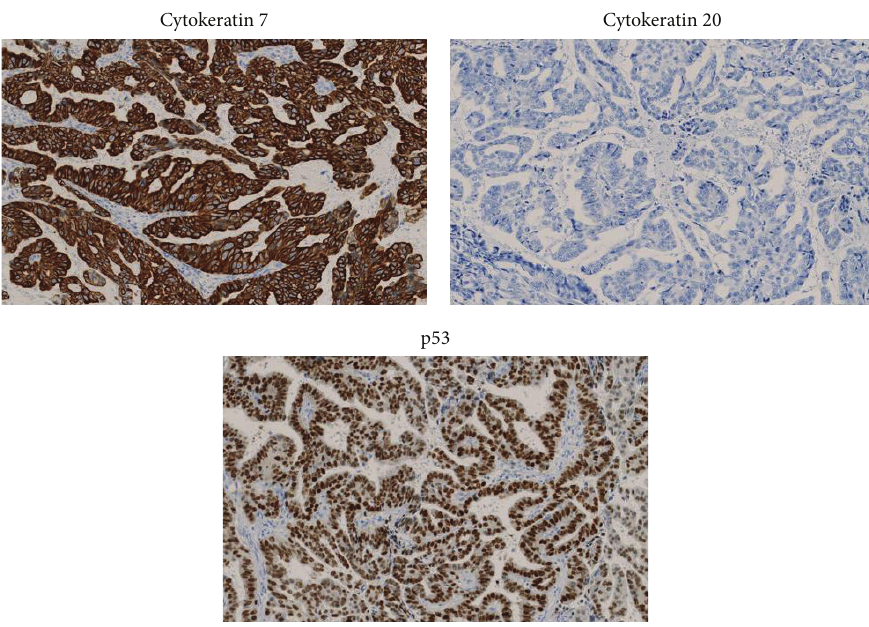
Figure 3: Immunohistochemistry of the anastomosis cancer. Immunohistochemistry demonstrated that these tumors were atypical as a colonic adenocarcinoma: positive for cytokeratin 7, negative for cytokeratin 20, and positive for